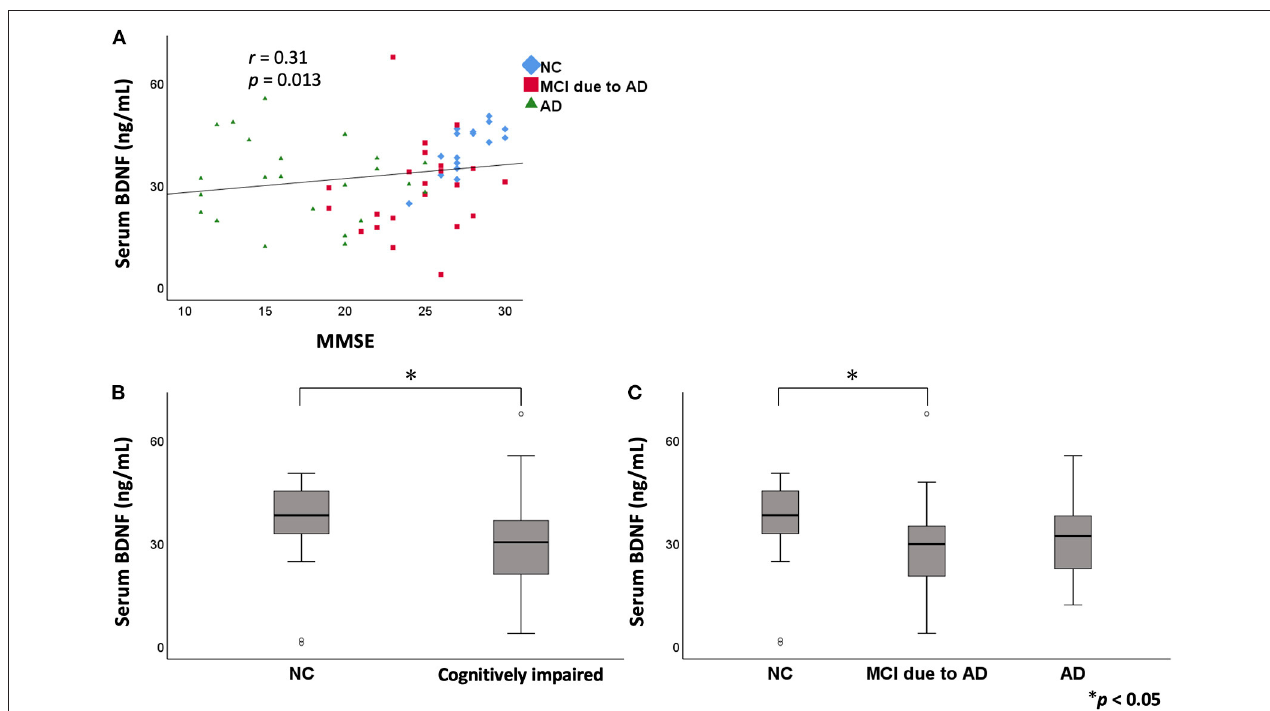
FIGURE 1 | The relation between serum BDNF levels and MMSE. Comparison of serum BDNF levels among NC, MCI due to AD, and AD groups. A positive correlation was found between serum BDNF levels and MMSE score ( r = 0.31, p = 0.013) (A) . On comparing serum BDNF levels between the NC group and cognitively impaired group (the MCI due to AD and AD groups), the cognitively impaired group had significantly lower levels than those of the NC group ( p = 0.015) (B) . BDNF serum levels were significantly different among the three groups ( p = 0.037). The MCI due to AD group had significantly lower serum levels compared to those of the NC group ( p = 0.037) (C) . BDNF, brain-derived neurotrophic factor; MMSE, Mini Mental State Examination; NC, normal control; MCI, mild cognitive impairment; AD, Alzheimer’s